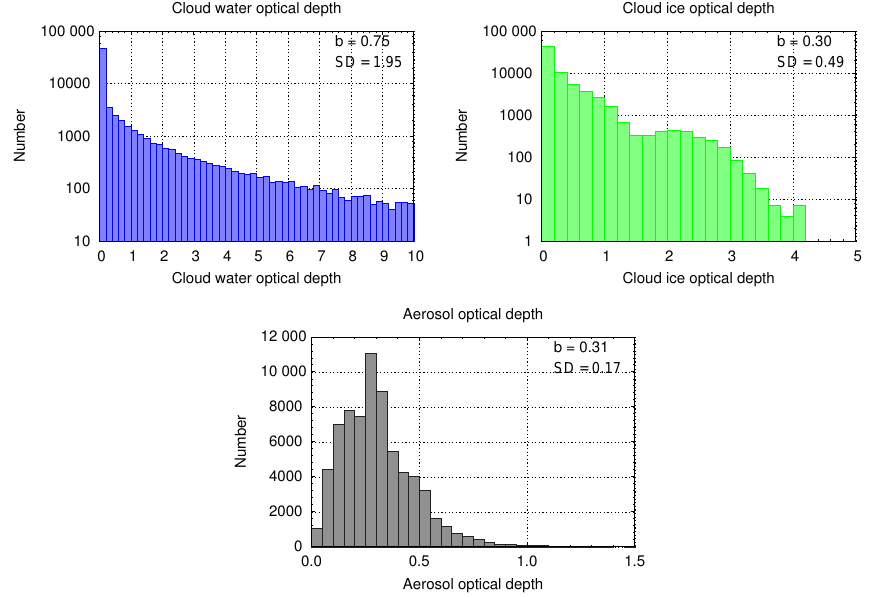
Figure 6. Histograms of the optical depths of cloud water, cloud ice and aerosol in the O 2 A-band for the cloudy simulations over Shanghai. The histogram of the optical thickness of cloud water extends to 40, but only the range standard deviations (SD) quoted are for the ensemble of